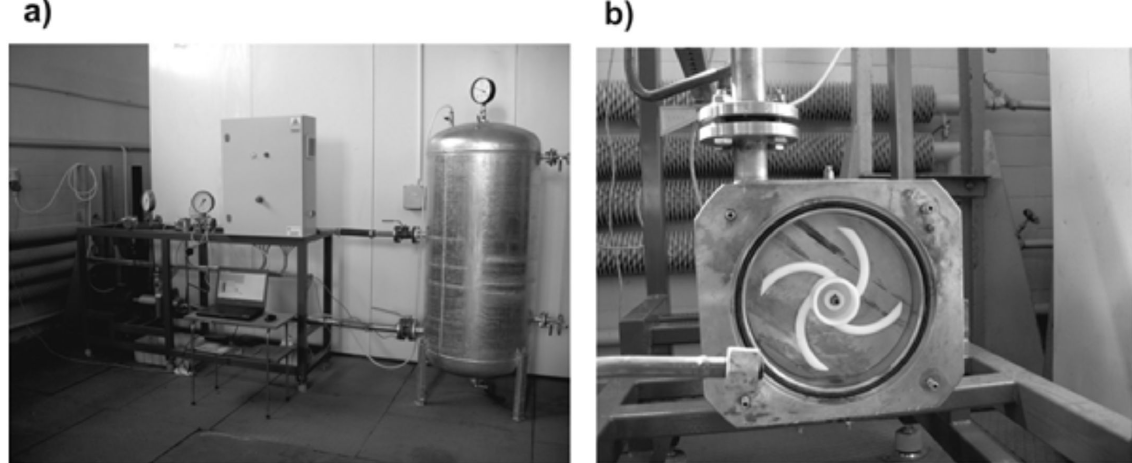
Figure 5: View of the test rig [9]